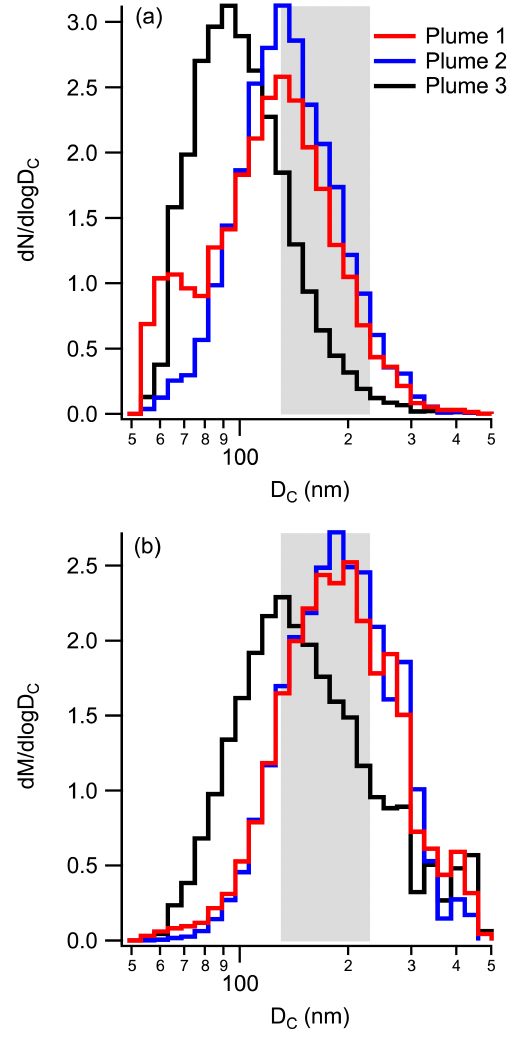
Figure 5. Normalised average BC core size distributions measured by the SP2 during the three plumes. Part (a) presents the number distribution, and part (b) the mass distribution. The discontinuity at ∼ 300nm is due to saturation of the broadband detector and switch- ing to the narrowband. The grey shaded regions show the range of core diameter used for calculating coating